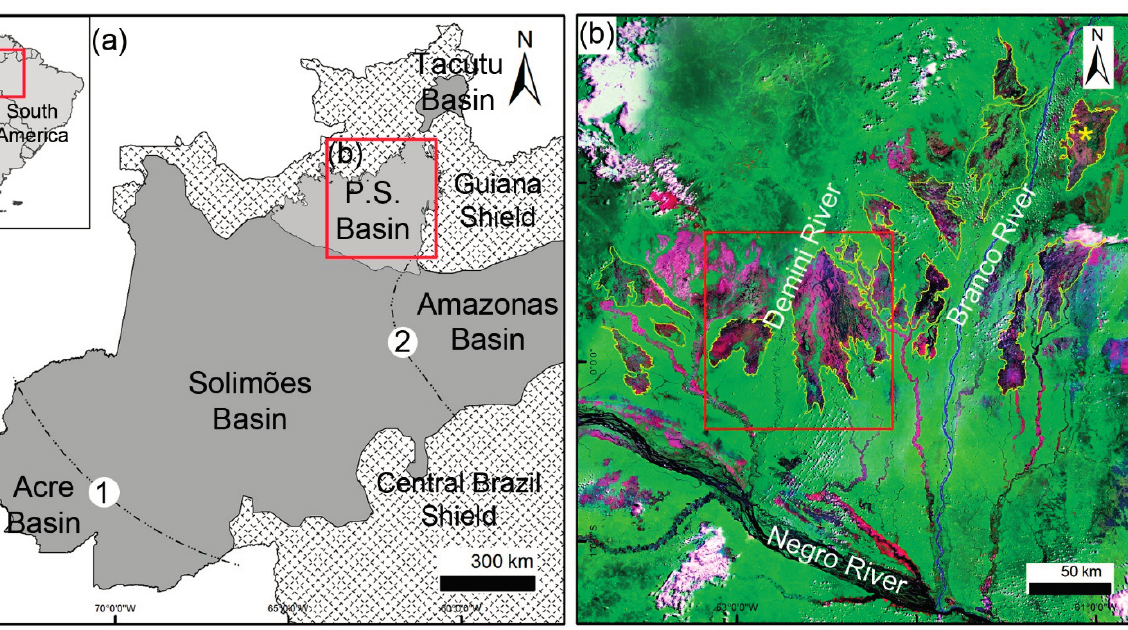
Figure 1. ( a ) Location of the study area in the sub-basin named Pantanal Setentrional (P.S), in the northeast of Solimões Basin. The Iquitos (1) and Purus (2) structural arches bound this basin to the west and east, respectively; ( b ) Geocover Landsat 2000 mosaic of the study area in composite color Red (band 7), Green (band 4) and Blue (band 2), illustrating open vegetation patches (pink) in sharp contrast with forest (green). The red square depicts the studied open vegetated areas with triangular-shaped morphology at the Demini